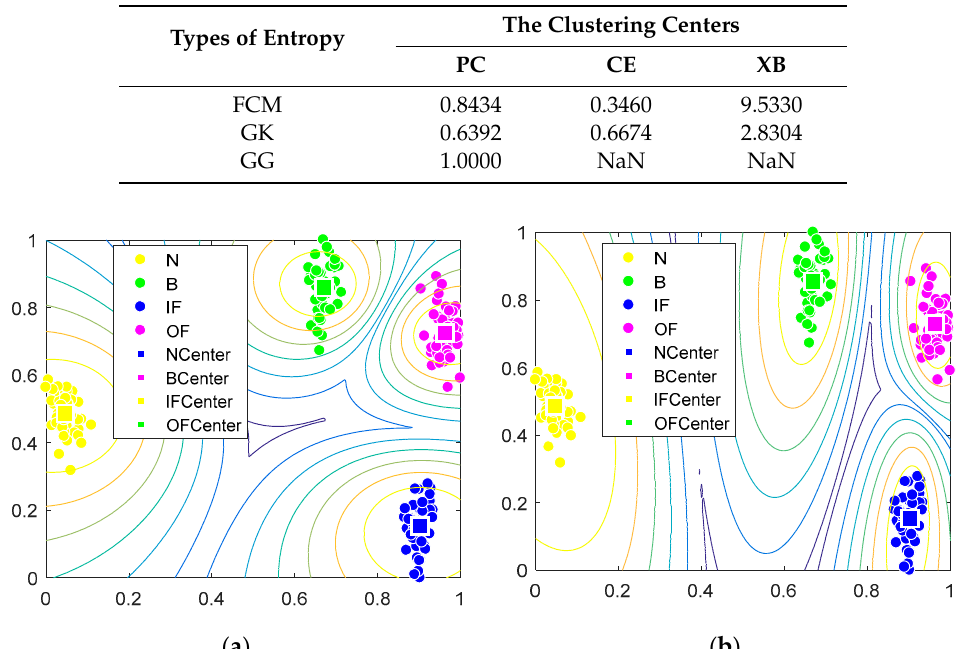
Table 6. The fuzzy c-means (FCM), Gustafson–Kessel (GK), and GG clustering index for signals.